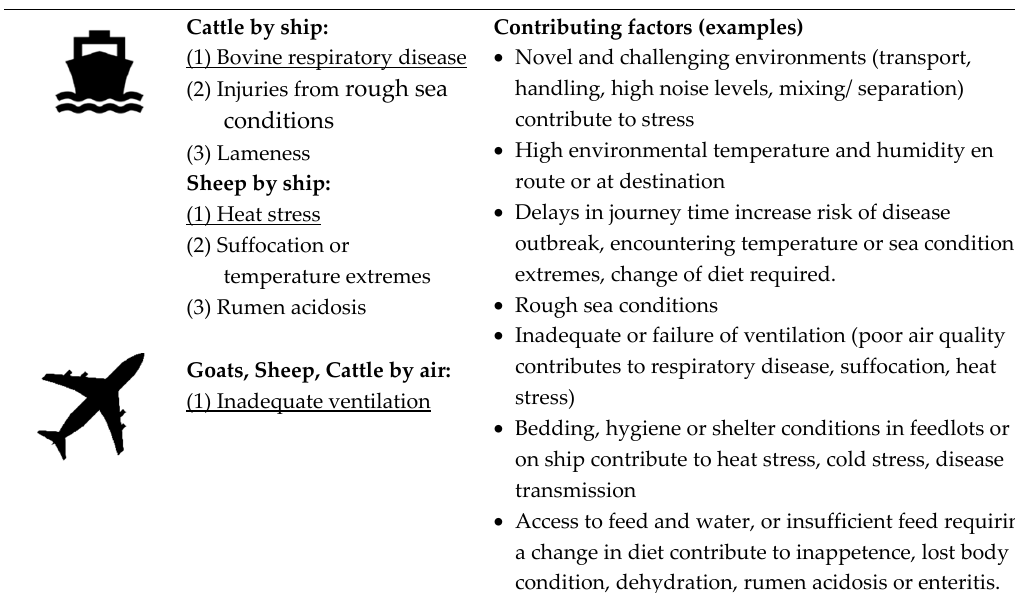
Figure 2. Main causes of mortality for livestock during sea and air transport for 23 notifiable incidences (2012–2016) where the level of mortality on a consignment exceeded the reportable mortality rate (reviewed under Investigations into Mortalities carried out by the Department of Agriculture, Water and Environment [66] ). Left are proximate causes of mortality identified by these investigations; those underlined were recorded for three or more of these investigations. Right are examples of contributing factors.